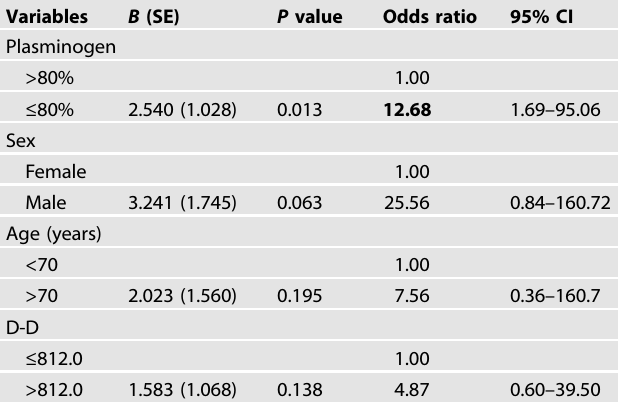
Table 3. Risk of death in COVID-19 patients (multiple logistic regression